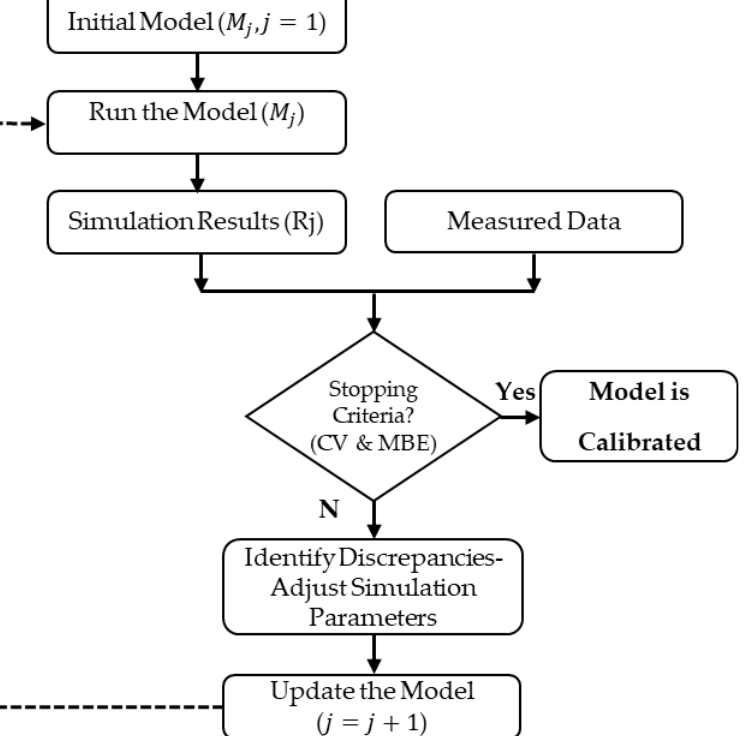
Figure 3. Iterative calibration process (partly adopted from [43]), where M j corresponds to the simulation model at iteration j and R j represents the results from the simulation at iteration j.